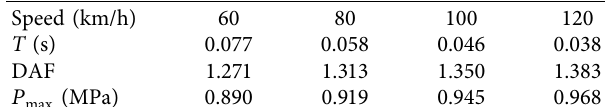
under different max